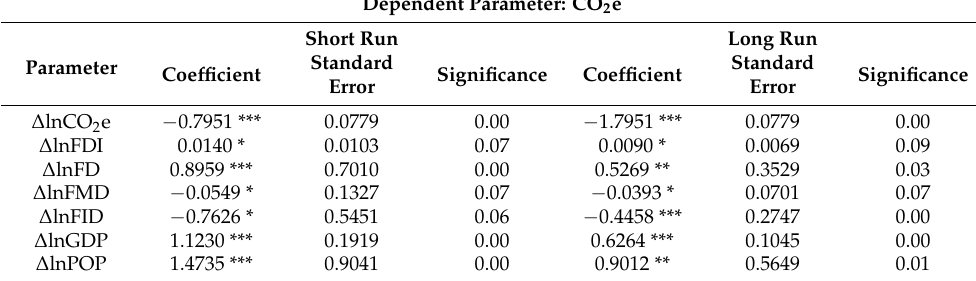
Table 7. CS-ARDL.